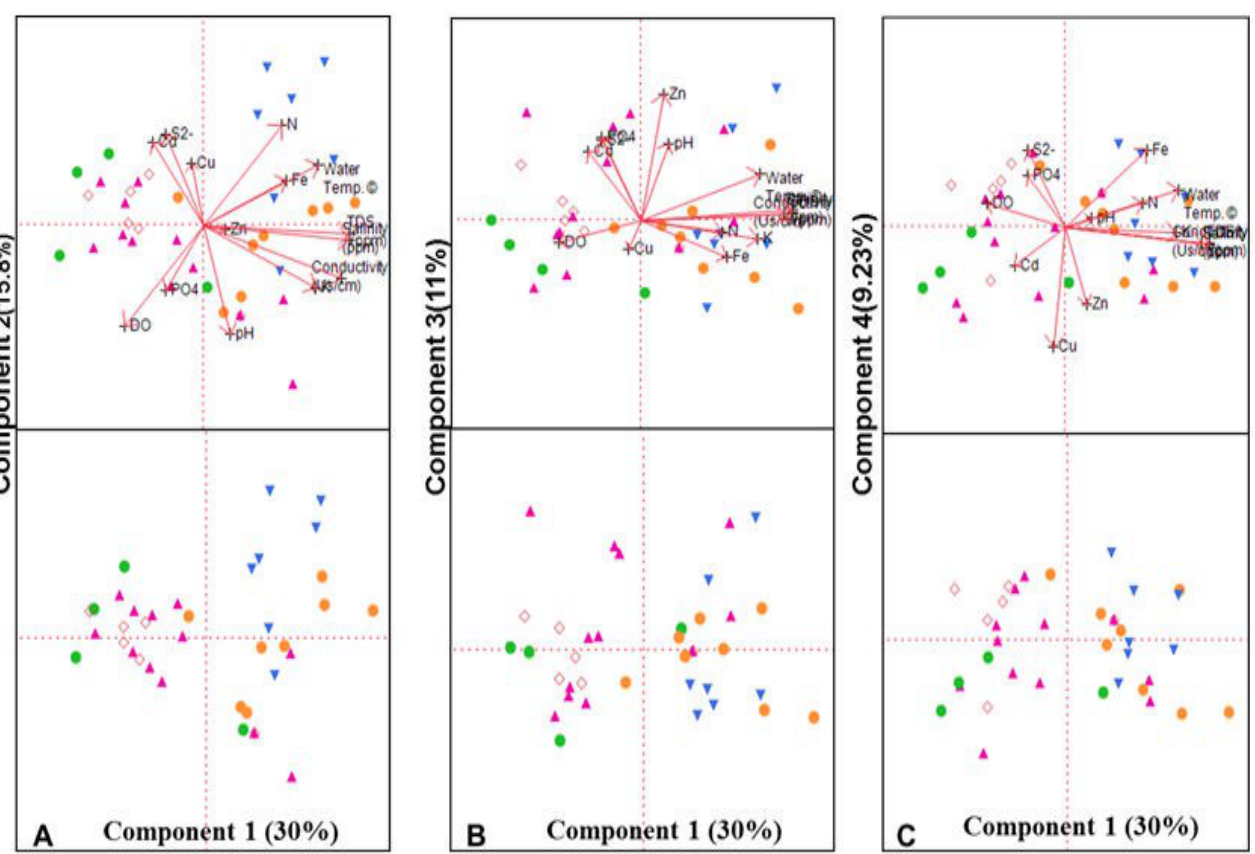
Figure 5. A group of three biplot panels displaying the PC loadings and component scores. ( A ) PC1 vs. PC2 explain highest variability in water quality ( i.e. , 30% and 15.8% respectively); ( B ) PC1 vs. PC3 illustrate moderate variation ( i.e. , 30% and 11% respectively); and ( C ) PC1 vs. PC4 illustrate lowest variation ( i.e. , 30% and